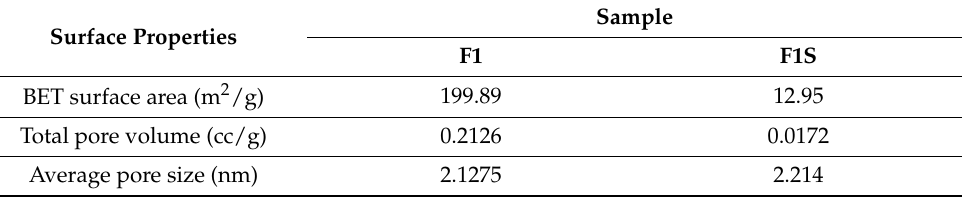
Table 2. The BET surface area, total pore volume, and average pore size of the F1 and F1S